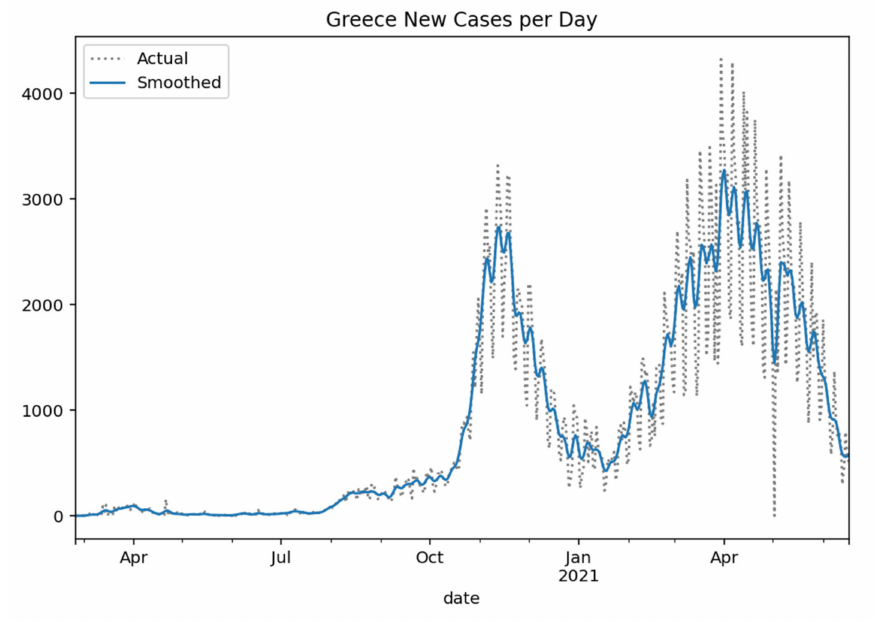
Figure 1. Greece new cases per day (Gaussian